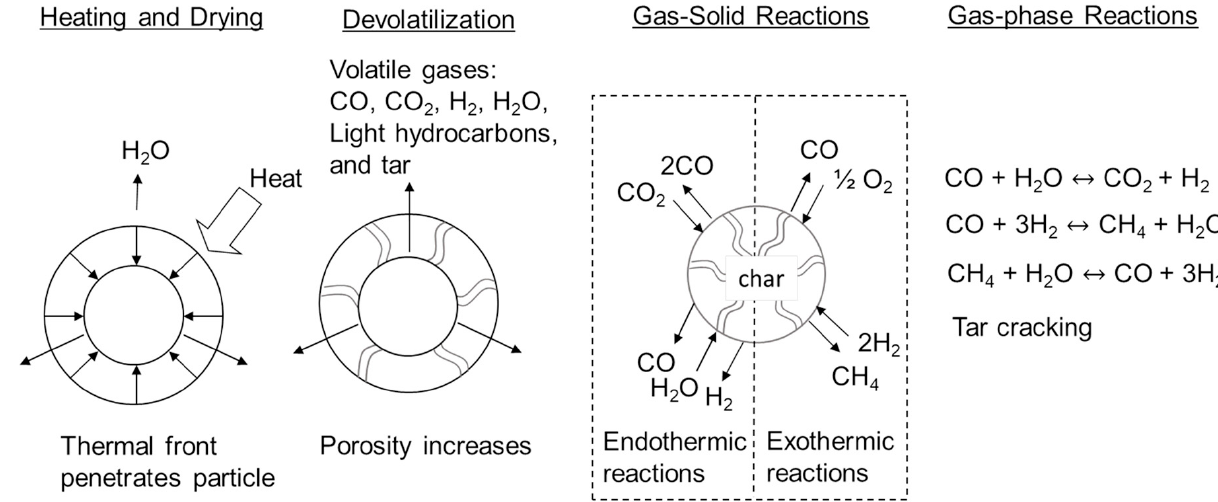
Figure 3. Fundamental steps in slow pyrolysis, fast pyrolysis and gasification. Note that devolatilization is generally endothermic while the gas-phase reactions as written are exothermic. (Adapted with permission from ref. [18]. Copyright 2014 Wiley Books.)